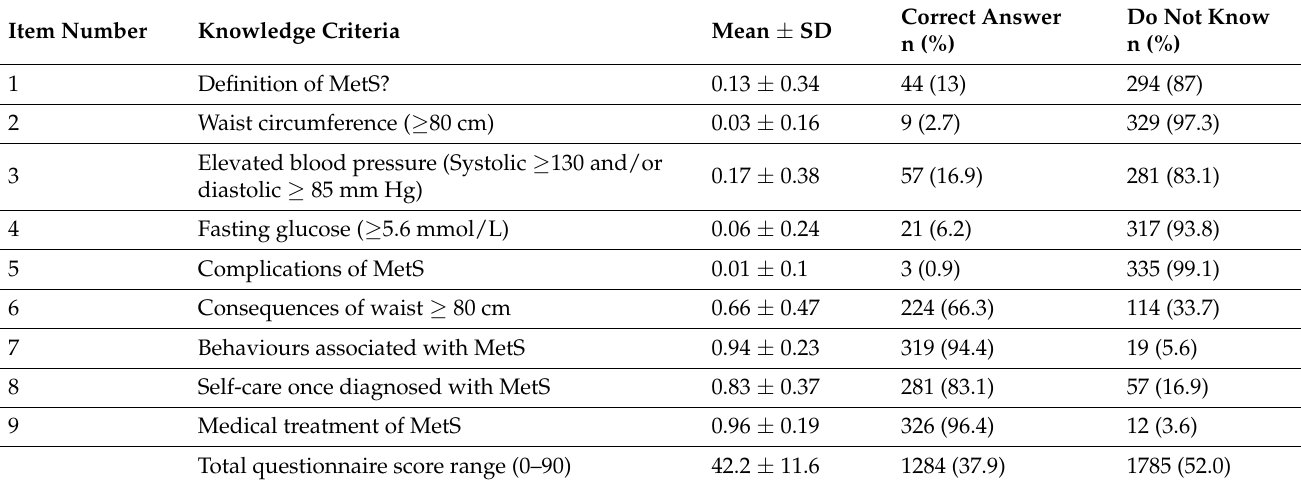
Table 3. MetS knowledge scores by scale